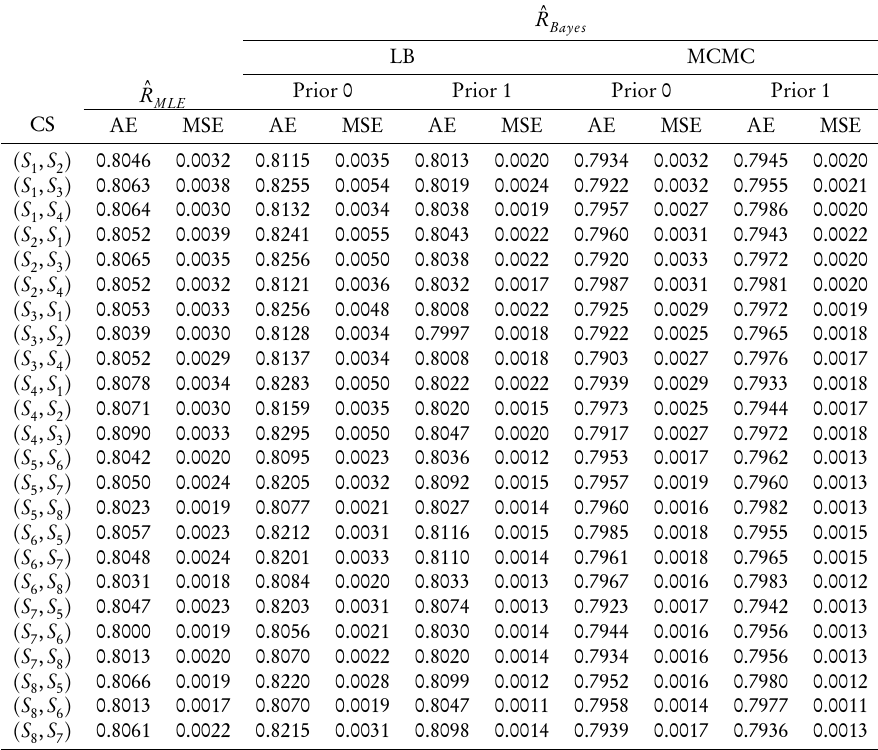
The AE and MSE of the ML and Bayes estimates of R when α = 0.75, β = 3, λ = 1 and R = 0.80.